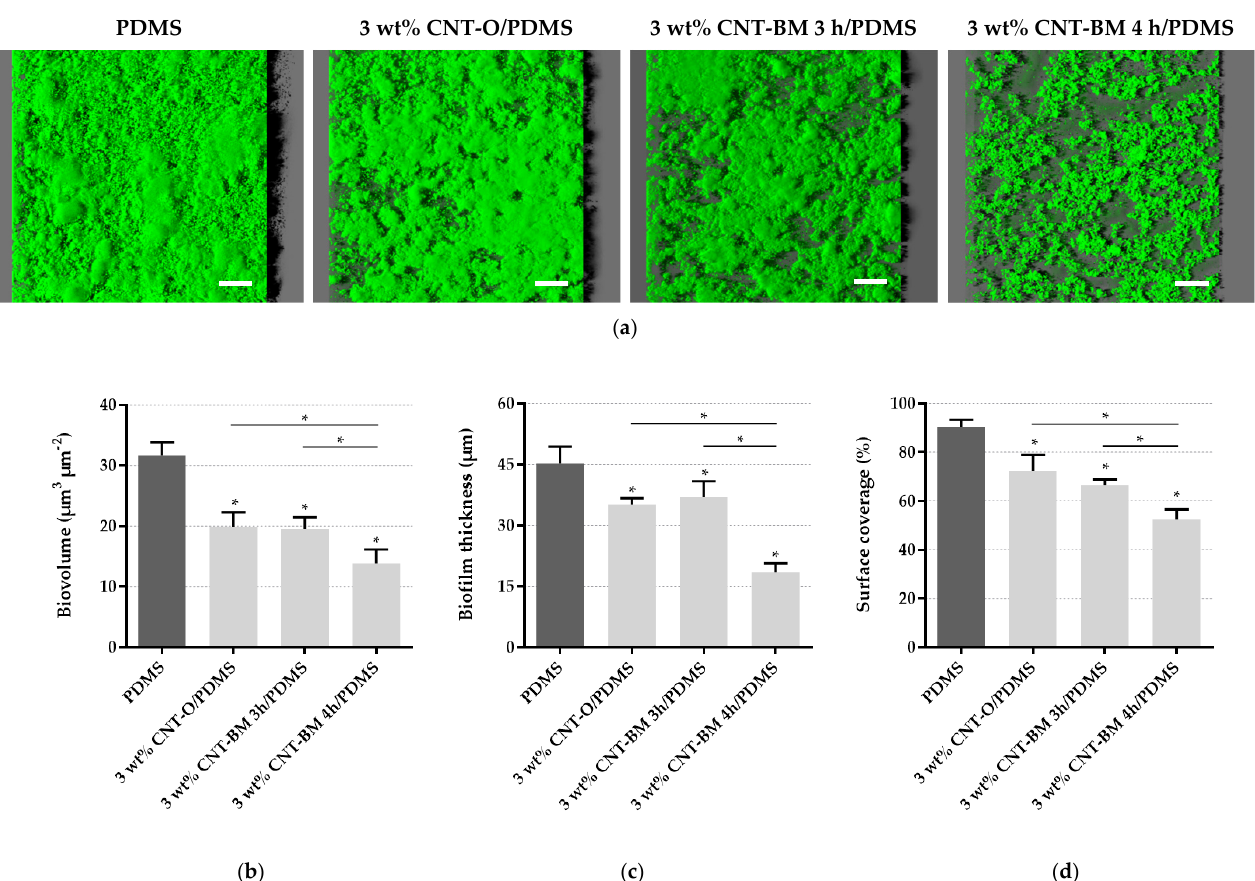
Figure 6. ( a ) Representative E. coli CECT 434 GFP biofilm structures on PDMS, 3 wt% CNT-O/PDMS, 3 wt% CNT-BM 3 h/PDMS and 3 wt% CNT-BM 4 h/PDMS. These images were obtained from confocal z -stacks using IMARIS software and present an aerial view of the biofilms (shadow projection on the right). The white scale bar corresponds to 50 µm. ( b – d ) Quantitative biofilm parameters obtained from the z -stacks: ( b ) biovolume, ( c ) thickness, and ( d ) surface coverage. The means ± SD for three independent experiments are illustrated. Significant differences were considered for p -values < 0.05 (* p < 0.01).